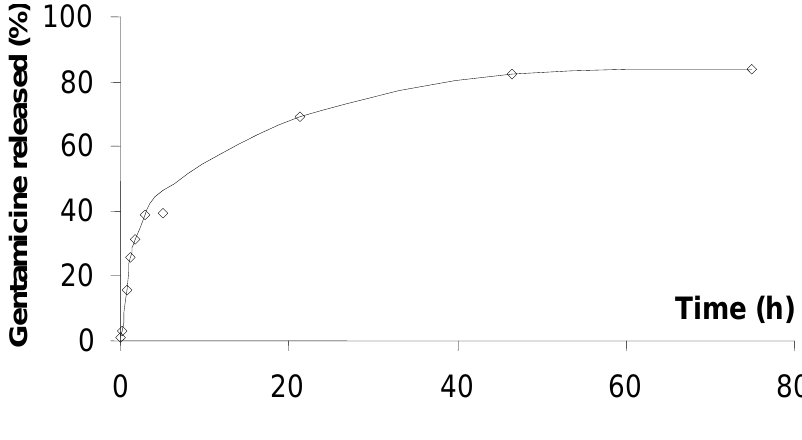
Figure 4. Gentamicine release from cement containing 2%